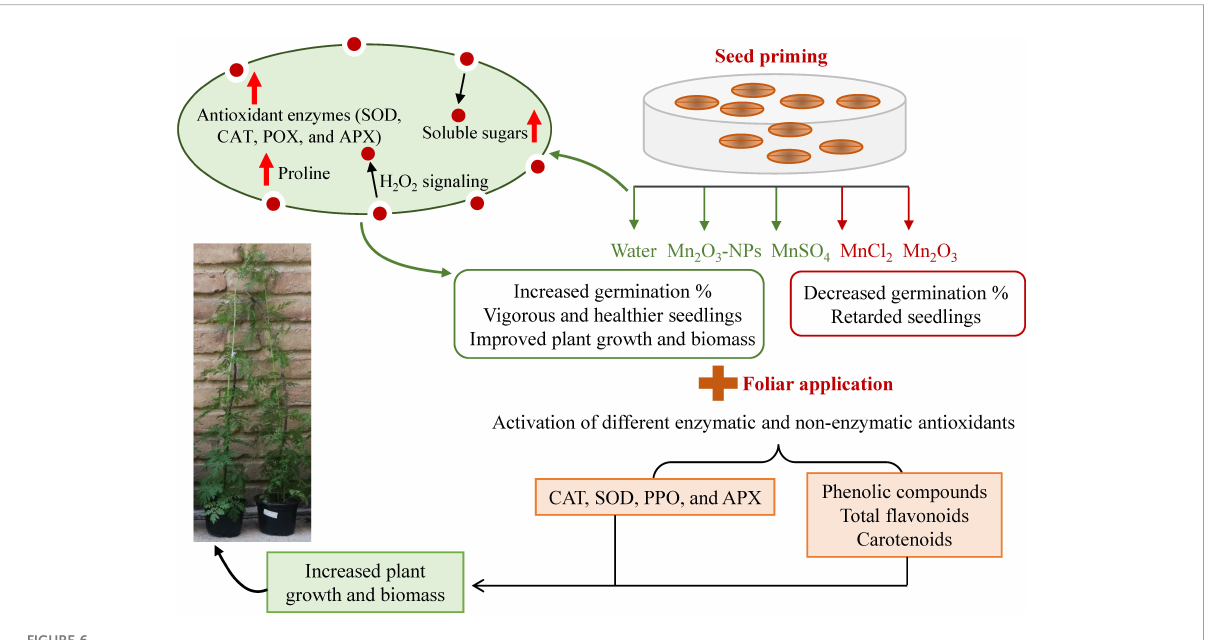
FIGURE 6 A schematic overview of the possible mechanism underlying improved plant growth and biomass based on different Mn